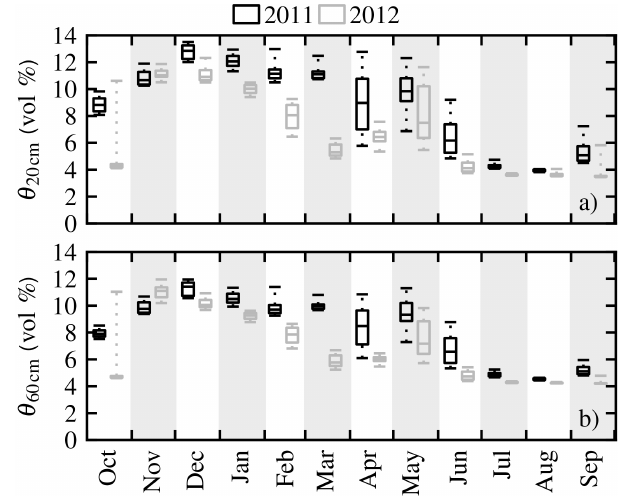
Figure 5. Box plot of monthly volumetric soil moisture (a) down to 20cm depth θ 20cm (root zone of understorey vegetation) and (b) down to 60cm depth θ 60cm for the years 2011 (black) and 2012 (grey). The central line marks the median, and the box marks the 0.25 and 0.75 quantiles. Dashed lines mark the 0.05 and 0.95 quan- tiles. Data within a 2day interval after a rain event were